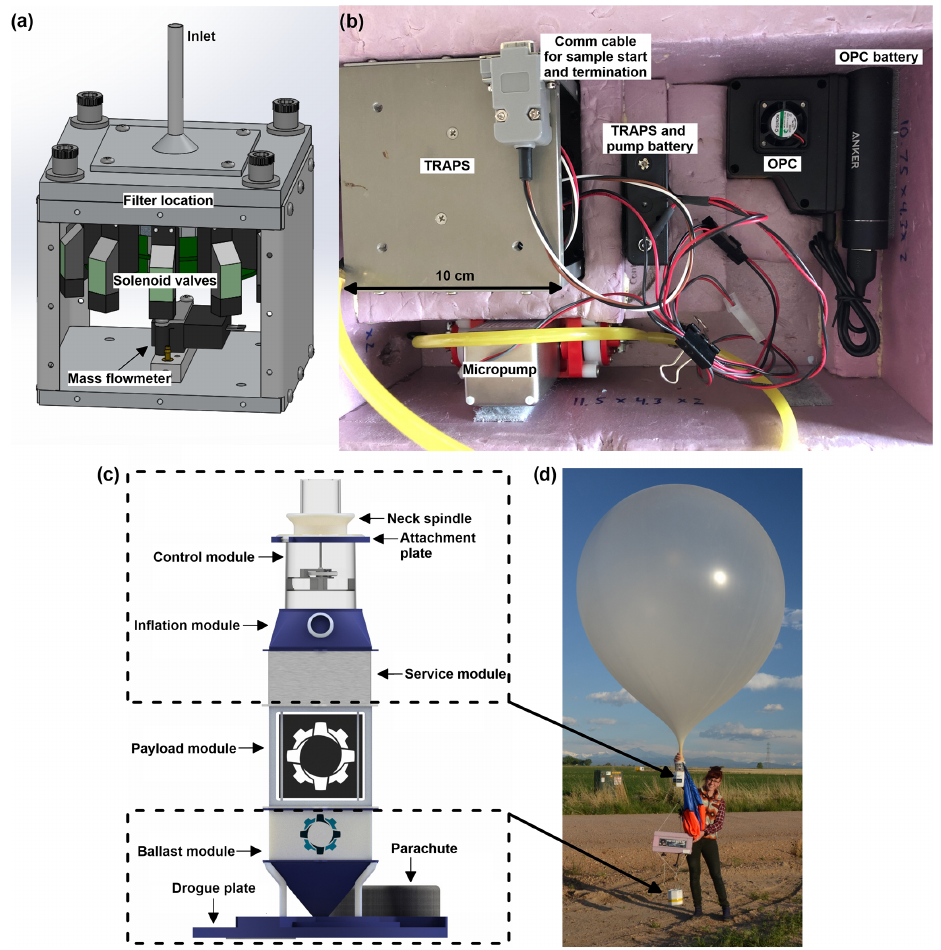
Figure 1. Components of the complete flight system, including (a) schematic of the TRAPS, (b) picture of the aerosol module, (c) schematic of the BBFCS, and (d) flight train for test flights. Note that the service module on the BBFCS was separated approximately 1m from the ballast module with the aerosol module (i.e., payload) in between. The ballast module was controlled by the onboard computer in the control module via an extended cable that ran down the tether string. The separated BBFCS modules were housed in foam for